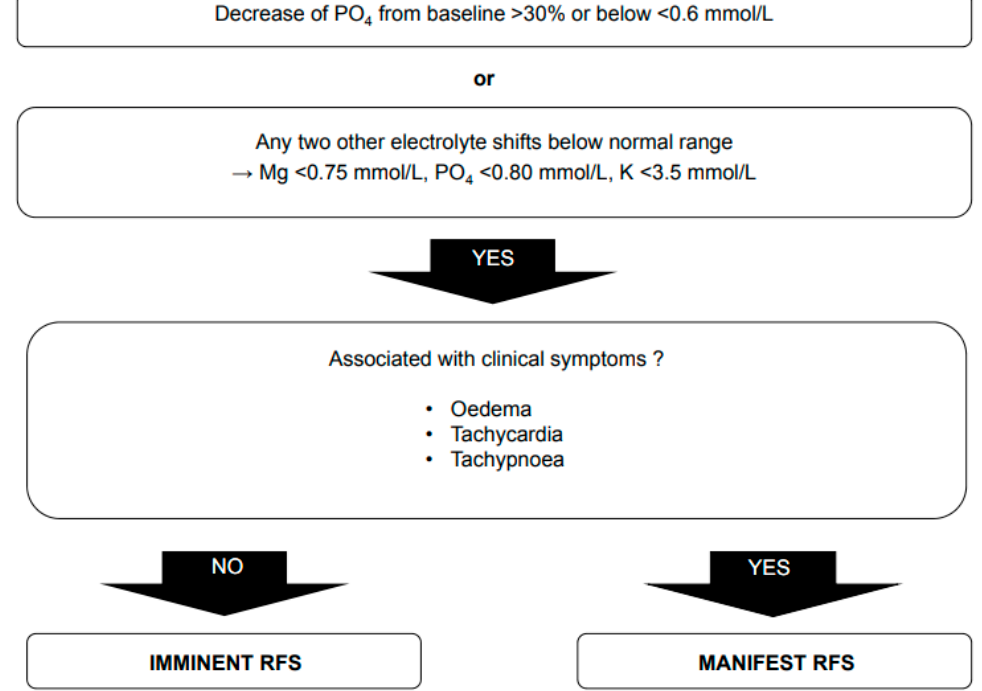
Figure 2. Diagnostic algorithm. Reprint with permission from Ref. [24]. 2017, Division of Diabetes, Endocrinology, Nutritional Medicine and Metabolism, University Hospital, Bern.